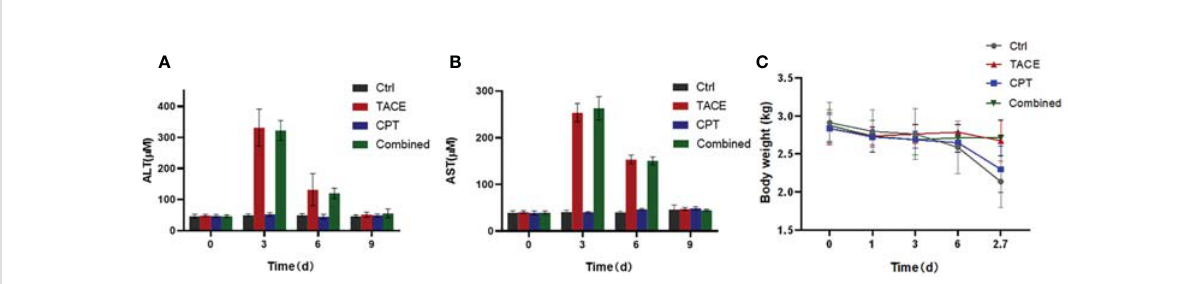
FIGURE 5 General physiological and biochemical assessment (A, B) . Drug-eluting bead transarterial chemoembolization (DEB-TACE) produced a clear image of liver function, which recovered 9 days after surgery. Concomitant use of camptothecin does not signi fi cantly impose an additional liver function burden on DEB-TACE. (C) With the continuous consumption of the tumor, the body weight of the Ctrl and CPT group continuously